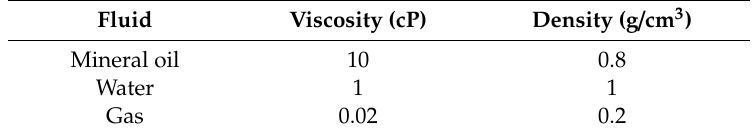
Table 2. Properties of experimental fluids under experimental conditions (90 ◦ C and 16